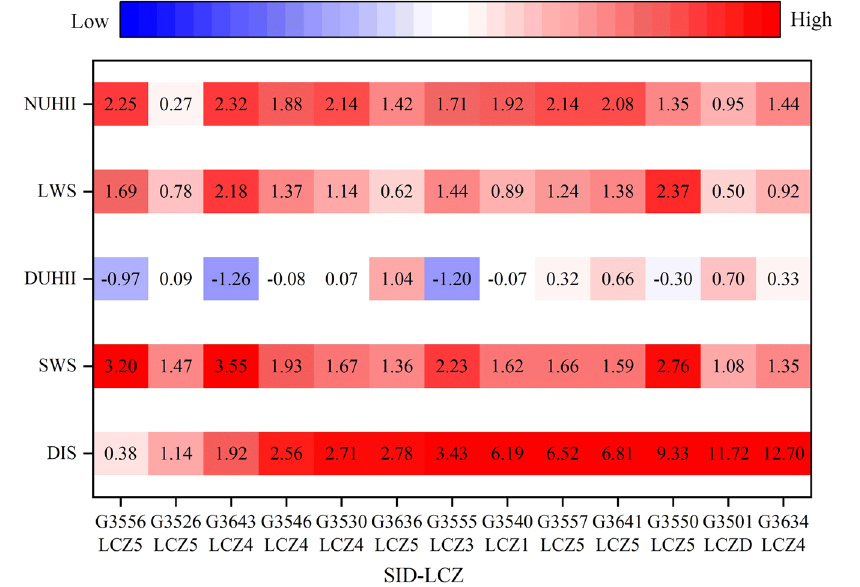
Fig. 8 The relationship between day and night UHII and sea – land wind speed, LCZ types, and distance to coastline at various weather stations. SID-LCZ indicates the station number and the type of LCZ to which it belongs, DIS stands for the distance between the station and the coastline, SWS and LWS represent wind speed of sea and land, respectively, DUHII and NUHII, respectively, represent the intensity of day and night heat